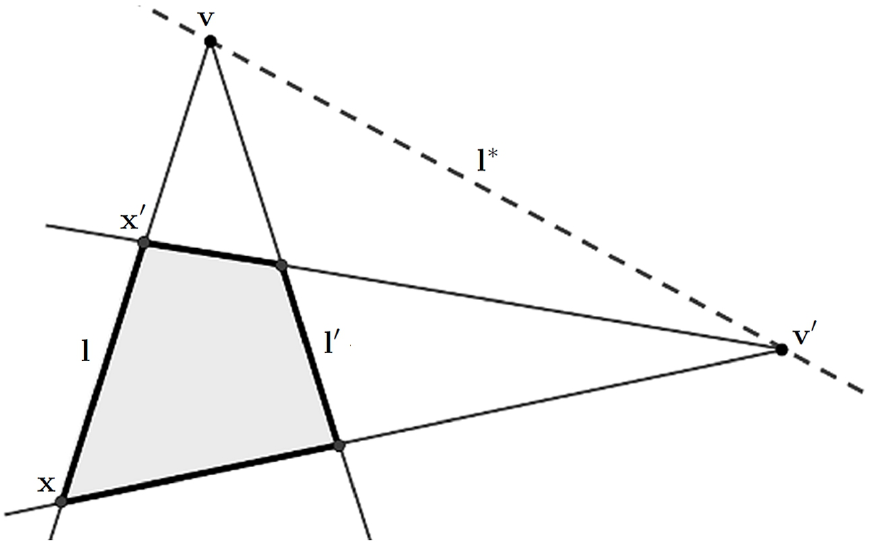
Figure 11. Residuals in meters for the different